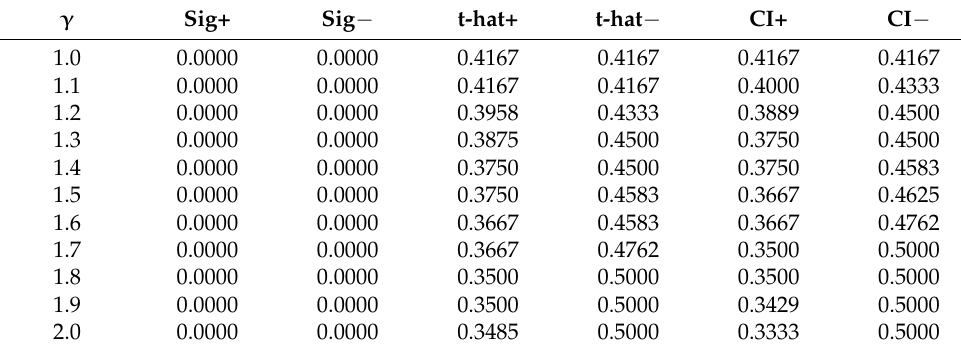
Table 7. Rosenbaum bounds sensitivity analysis.